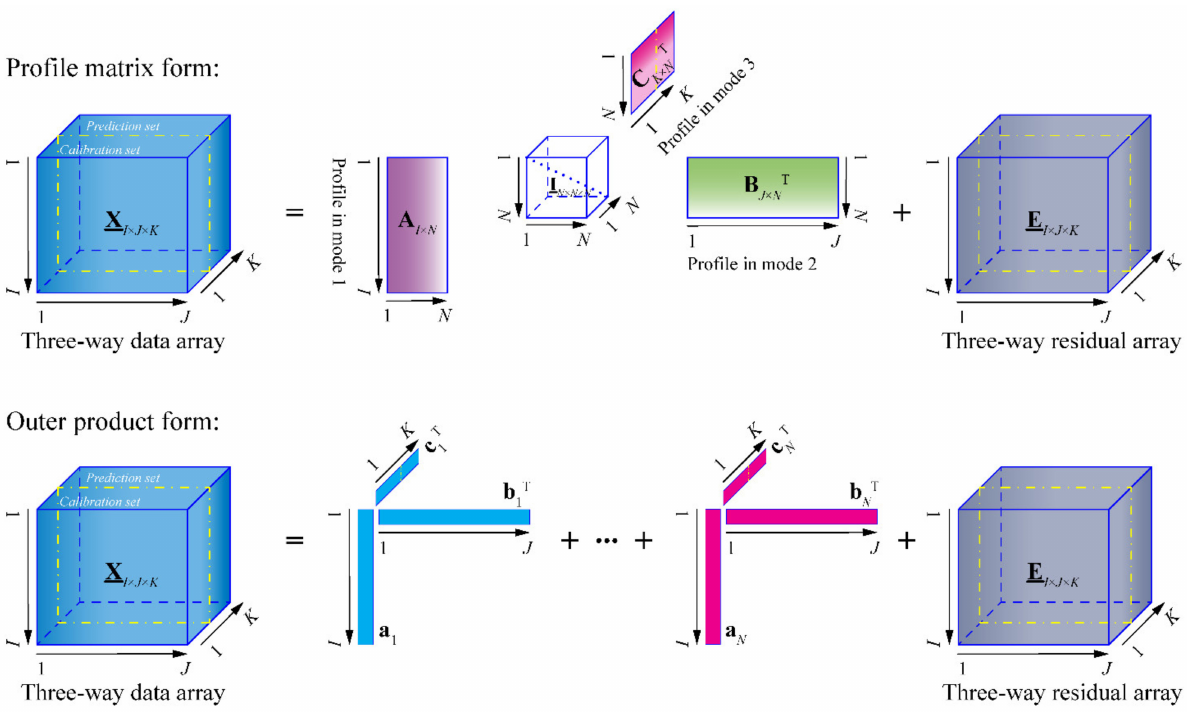
Figure 2. Illustration of the trilinear decomposition in profile matrix and outer product